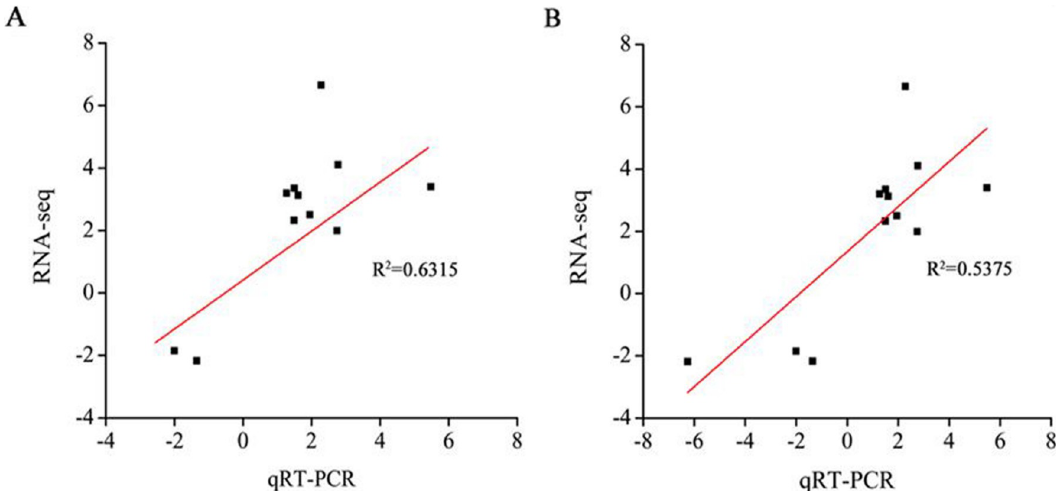
Fig 7. Verification of the differentially expressed genes in the control vs. drought stress group (A) and the control vs. re-watering group (B) by